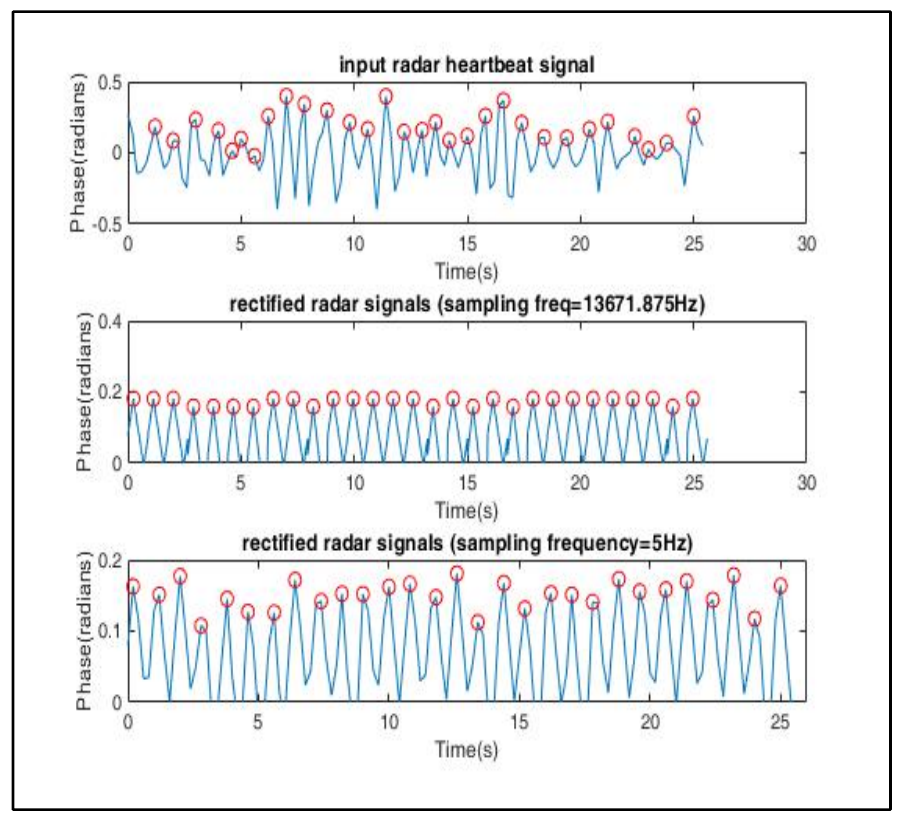
Figure 12. Signal reconstruction using symmetric triangular wave function, which was then down sampled to 5 Hz to match the sampling frequency of the ECG signals used in the training dataset.